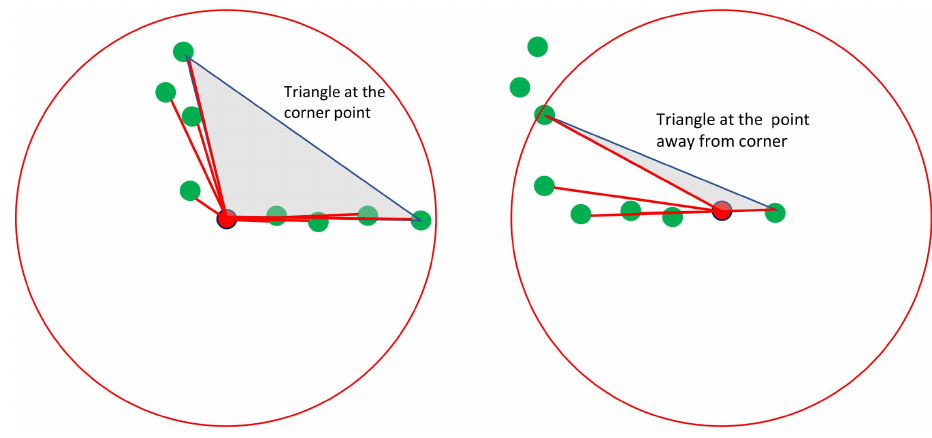
Figure 7. A FALKO-based corner detection example presented in [2].